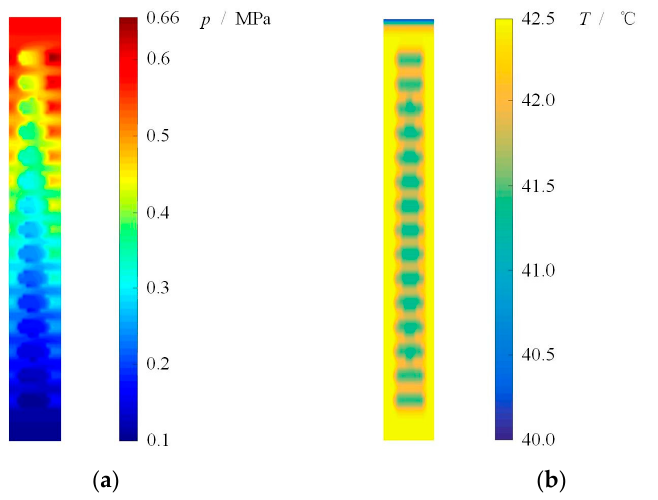
Figure 2. Textured seal ring with circle-dimples.